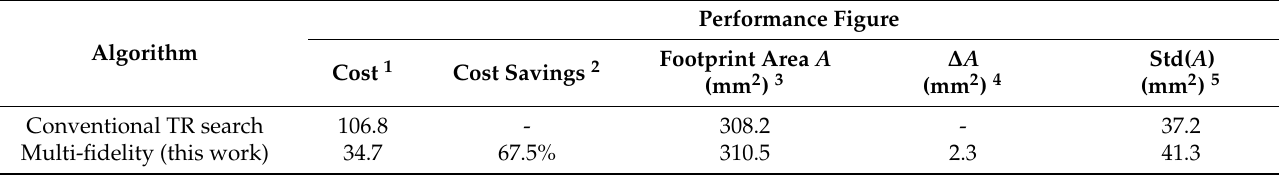
Table 3. Numerical Results for Antenna